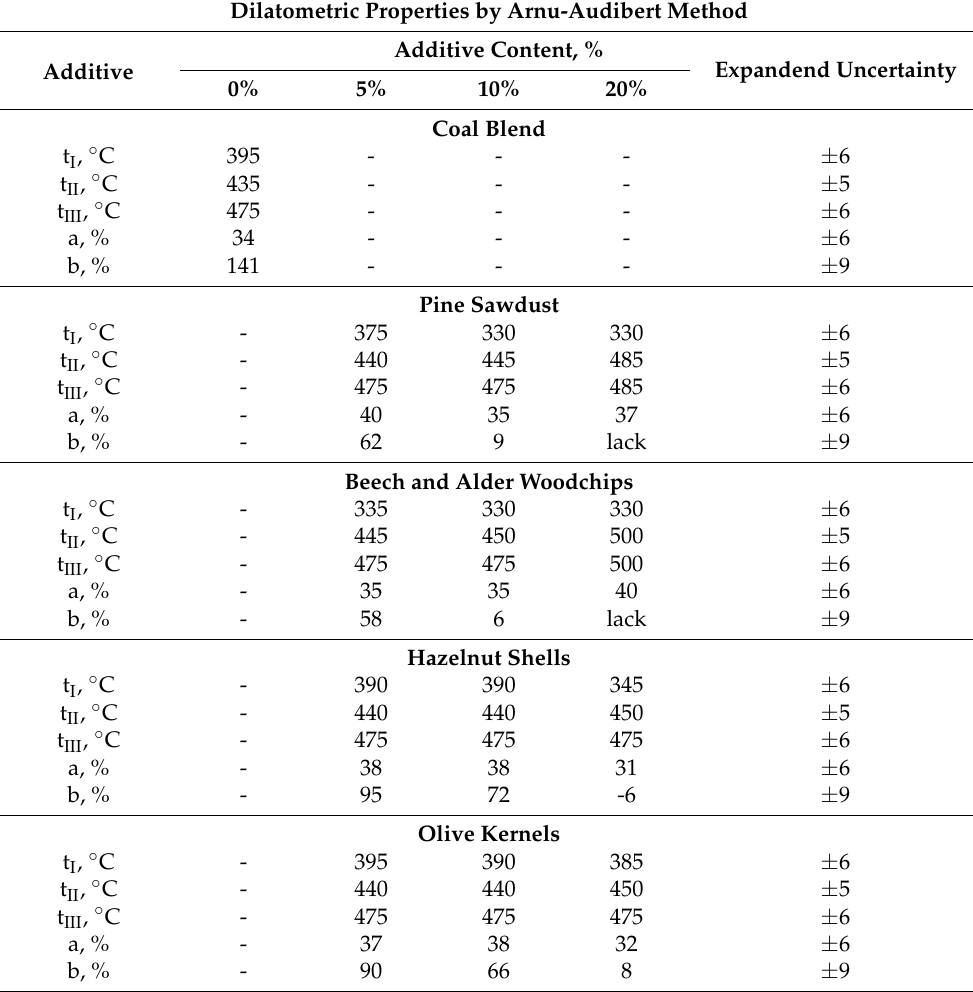
Table A4. The influence of raw biomass supplementation on dilatometric properties by Arnu– Audibert